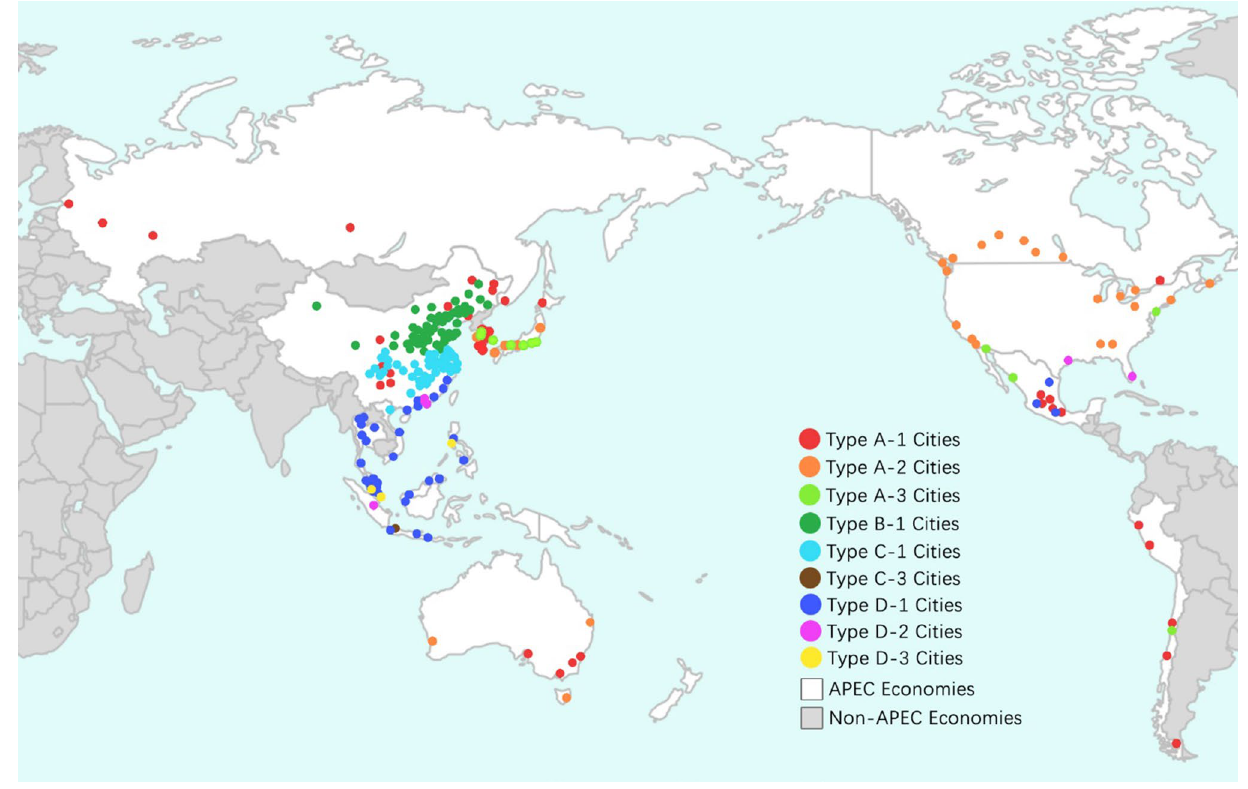
Fig. 6 Spatial pattern of all types of